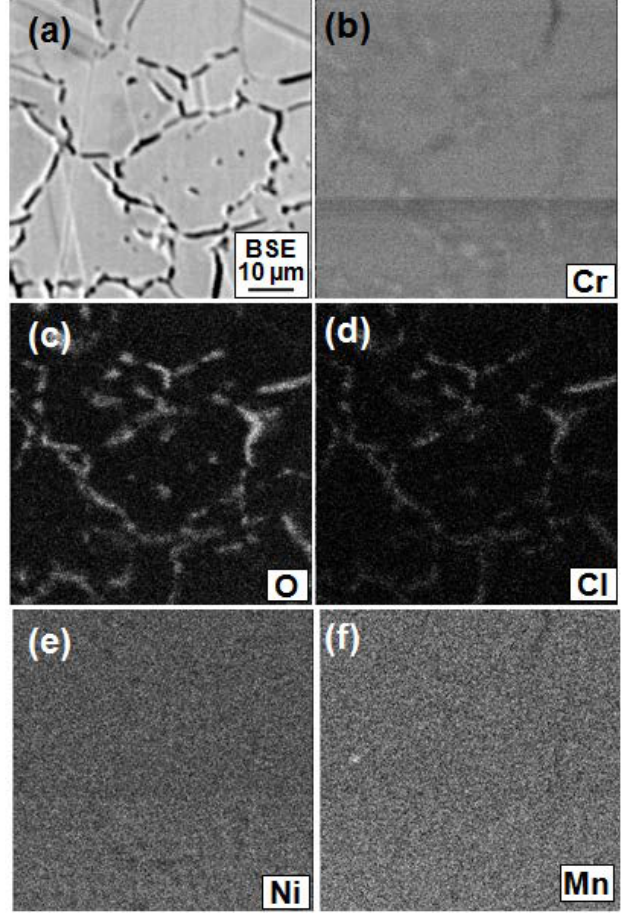
Figure 4: (a) BSE micrograph and X-ray elemental distribution mappings: (b) Cr, (c) O, (d) Cl, (e) Ni and (f) Mn obtained by EPMA technique.